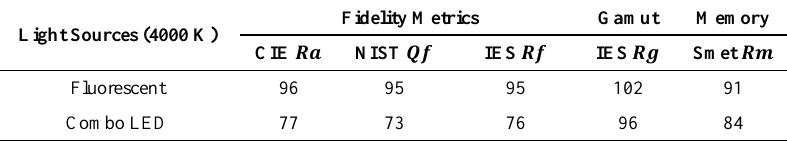
Table 1. Some of the colour properties of the two randomly selected sources used in the earlier case study Light Sources (4000